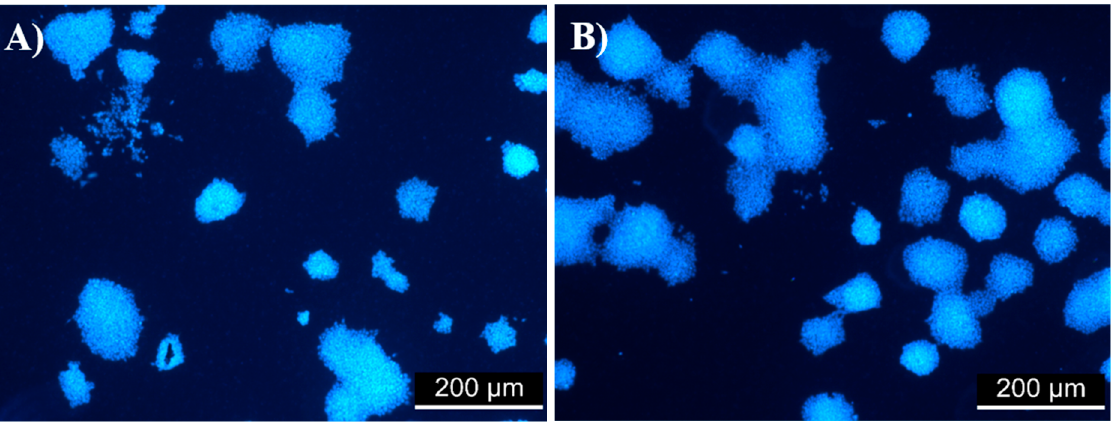
Figure 5. Cell viability of individual samples. The dashed line highlights the limit of viability according to EN ISO 10993-5: viability < 0.7 corresponds to a cytotoxic effect. ( A ) Comparison of reference (cells on TPP plastic) and PET; ( B ) Comparison of reference (cells on TPP plastic coated with gelatine) and PET coated with gelatine; ( C ) Comparison of PET as a reference and samples; ( D ) Comparison of PET coated with gelatine as a reference and samples also coated with gelatine. Data are reported as the means and standard deviations from a minimum of four independent experiments. To determine significant differences between samples ANOVA with post hoc Tukey’s Multiple Comparison test was used; ** p < 0.01, *** p < 0.001.